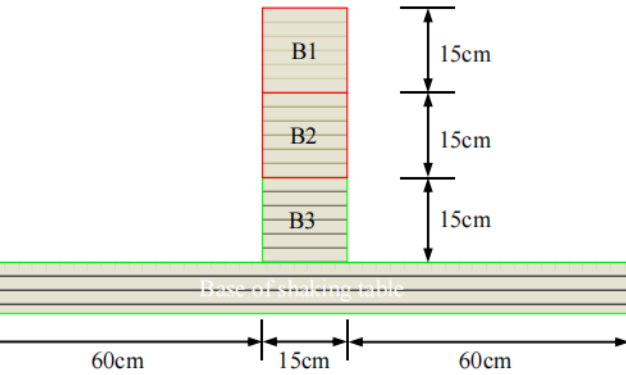
Figure 15. Physical model of the assembled blocks standing on the shaking table. Figure 16. Numerical model of the assembled block system by the NMM.